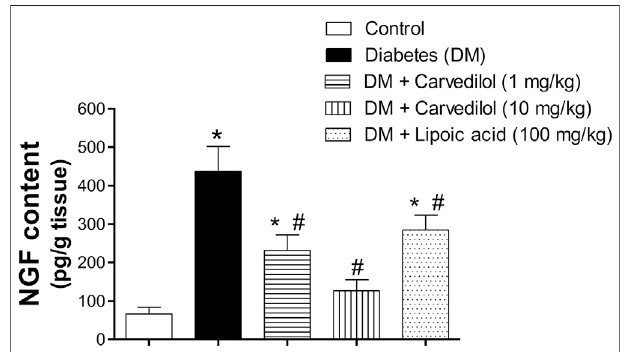
FIGURE 6 | Effect of carvedilol on the NGF content in the DRG tissue of STZ-induced diabetes in rats. Data are presented as mean ± SD for each group ( n (cid:2) 6). *Statistically signi fi cant from the corresponding control group at p < 0.05.#Statisticallysigni fi cantfromthecorrespondingdiabetesgroup at p < 0.05. DM, diabetes mellitus; DRG, dorsal root ganglion; NGF, nerve growth factor; SD, standard deviation; STZ,